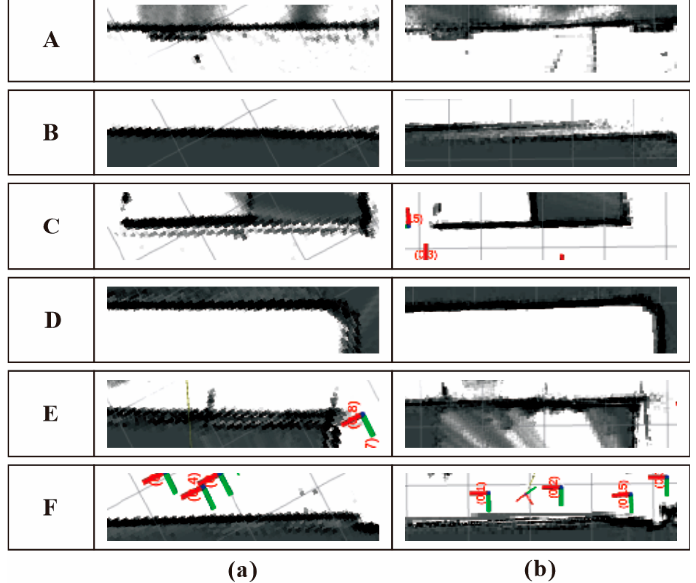
Figure 13. Comparison of map details created by different methods, and A–F are six selected com- parison sub-regions. ( a ) The map was constructed by APF algorithm. ( b ) The map was constructed by Cartographer algorithm.